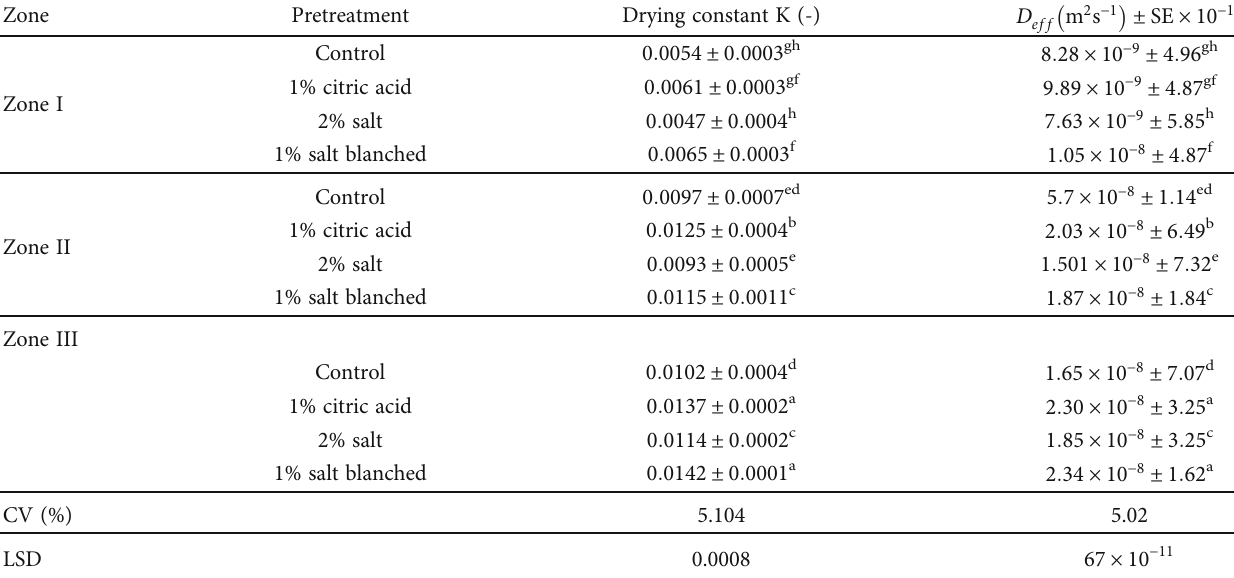
Values expressed are mean values of threereplicates ± standarderror . All mean scores, bearing di ff erent superscript in columns di ff er signi fi cantly ( P ≤ 0 : 05